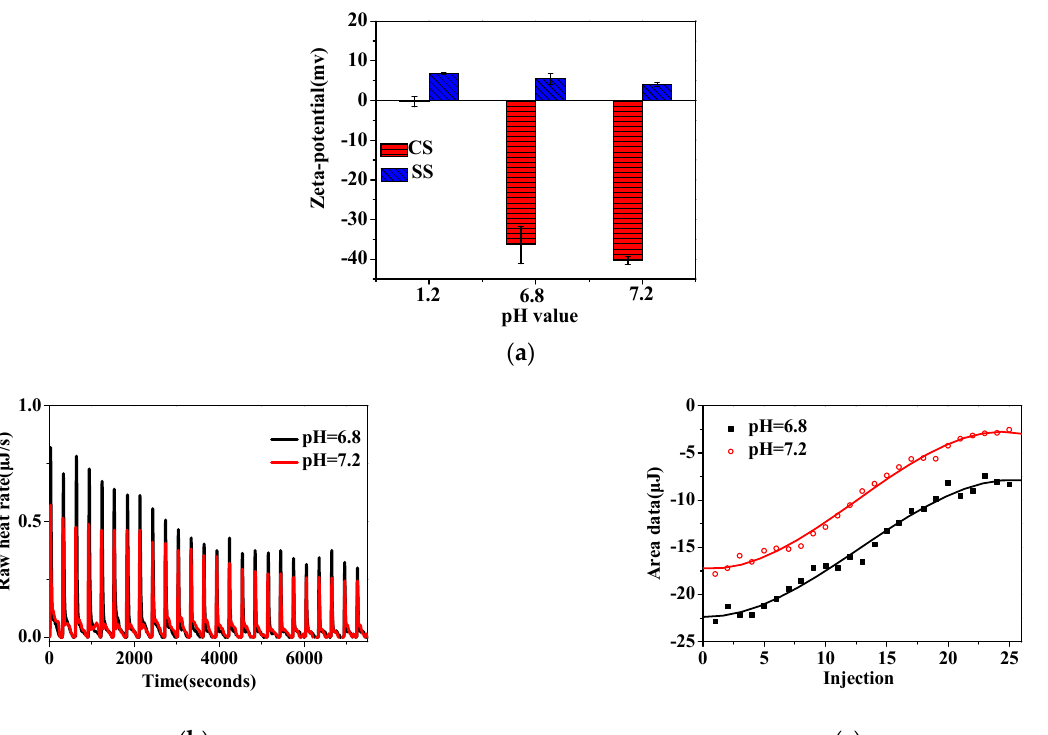
Figure 4. Zeta − potential ( a ) and integrated enthalpy ( b , c ) of the interactions between CS and SS at GIT pH. Abbreviations: CS, carboxymethyl anionic starch; and SS, spermine cationic starch. At pH 1.2, the CS was slightly negatively charged, while SS and protein carried a